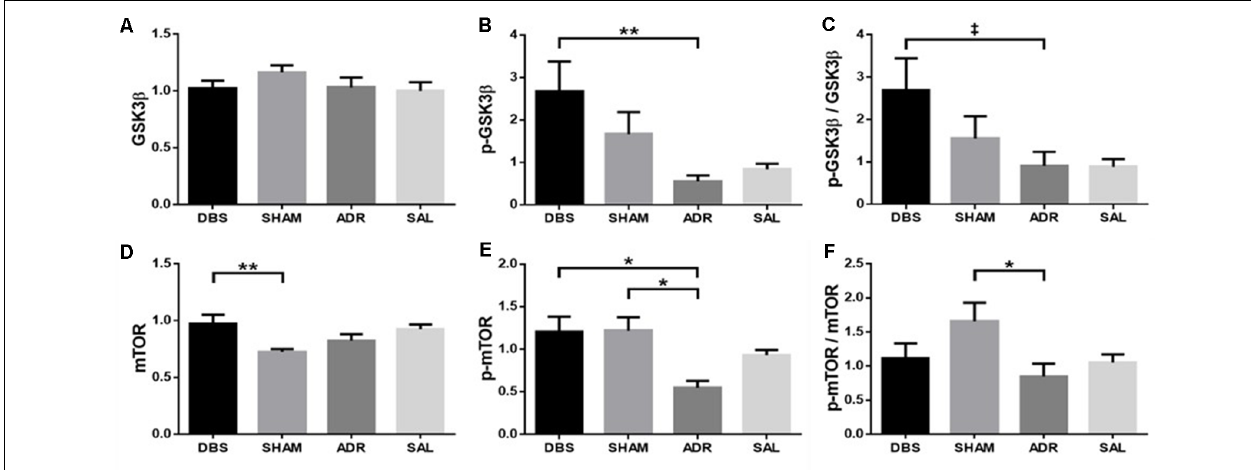
FIGURE 7 | vHipp protein expression levels of (A) GSK3 β , (B) p-GSK3 β , (C) p-GSK3 β /GSK3 β , (D) mTOR, (E) p-mTOR, (F) p-mTOR/mTOR. Data are shown as mean concentration standardized to β -actin and normalized to SAL controls for each gel ± standard error. Significance is illustrated on graphs by * p < 0.05; ** p < 0.01. Trends illustrated as ‡ p < 0.1.